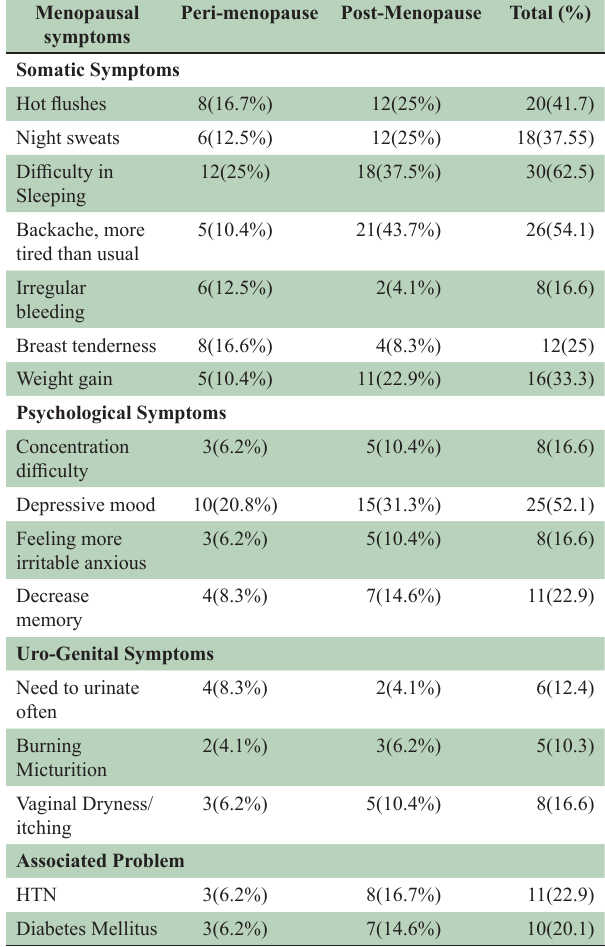
Table-III: Symptoms Experienced by Women.